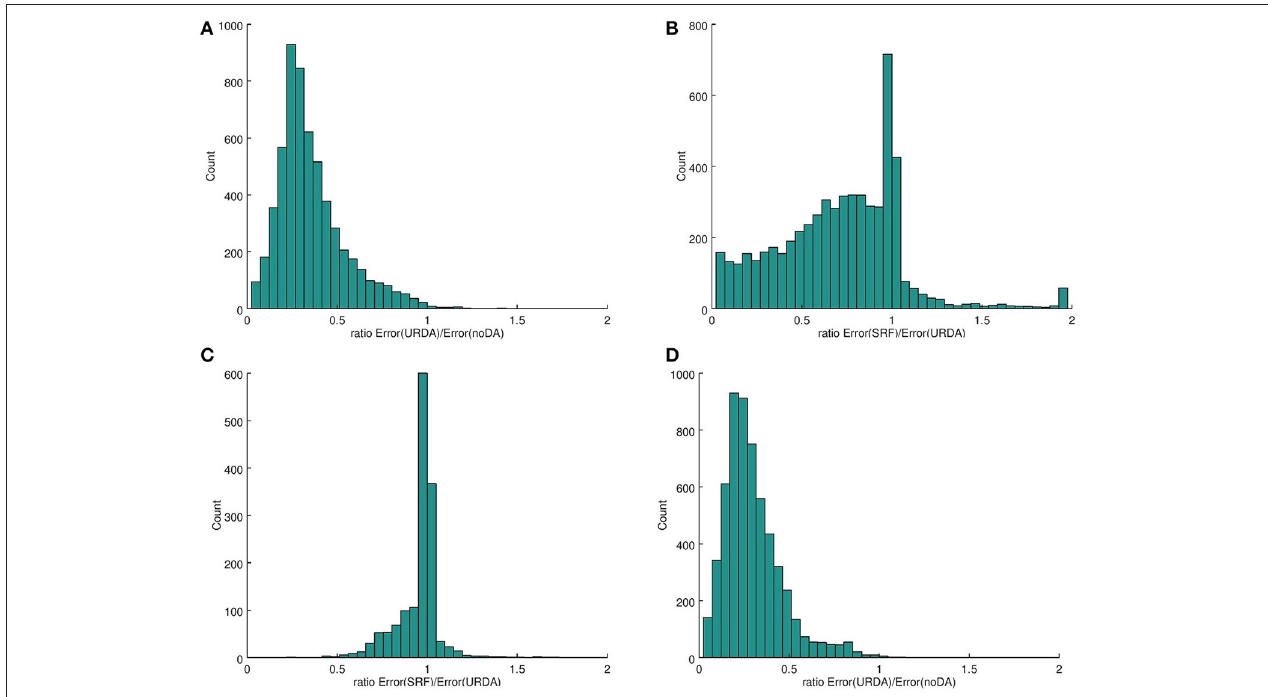
FIGURE 4 | We show the results of the mean-error of the ultra rapid data assimilation in comparison with the original first guess (no data assimilated) and the ensemble Kalman square root filter for the Lorenz 1963 model. We used N stat 250 different initializations of the random number generator to obtain different = distributions for the observations and the initial ensemble. After assimilation of all data the mean error at each time step on the trajectory from the truth is counted. In (A,B) we used L 5 and N 25 to obtain histograms showing in (A) the ratio of the mean-error of URDA divided by the mean-error of the model forecast without = = data assimilation. For L 5 in (B) the mean-error of the SRF divided by the one of URDA is displayed for N 25 while the same is shown for N 8 in (C) . The ratio of = = = the mean-error of URDA divided by the initial forecast for N 25 and L 25 in (D) = =